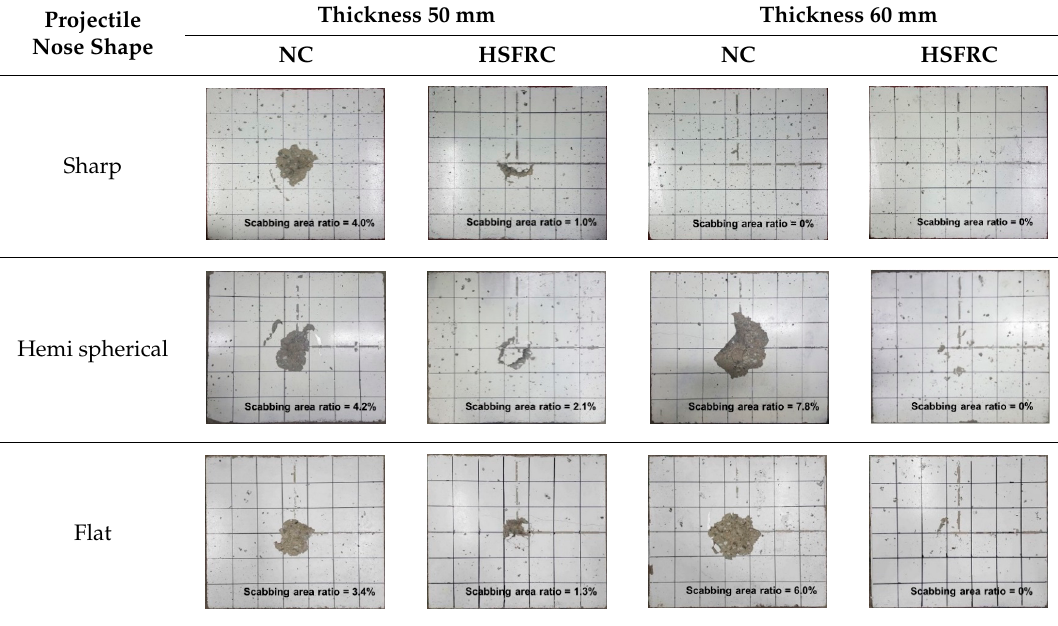
Table 6. Impact fracture on rear face.